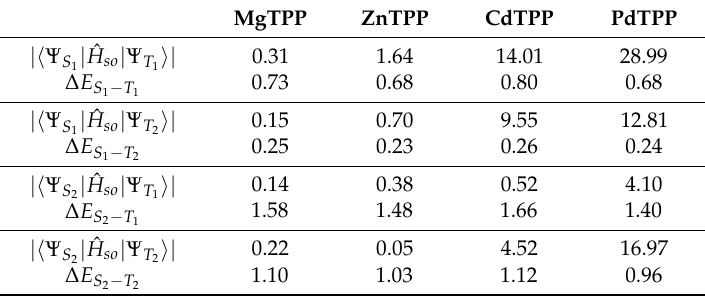
Table 2. SOC values (cm -1 ) and energy gaps ( ΔE (cid:2903)